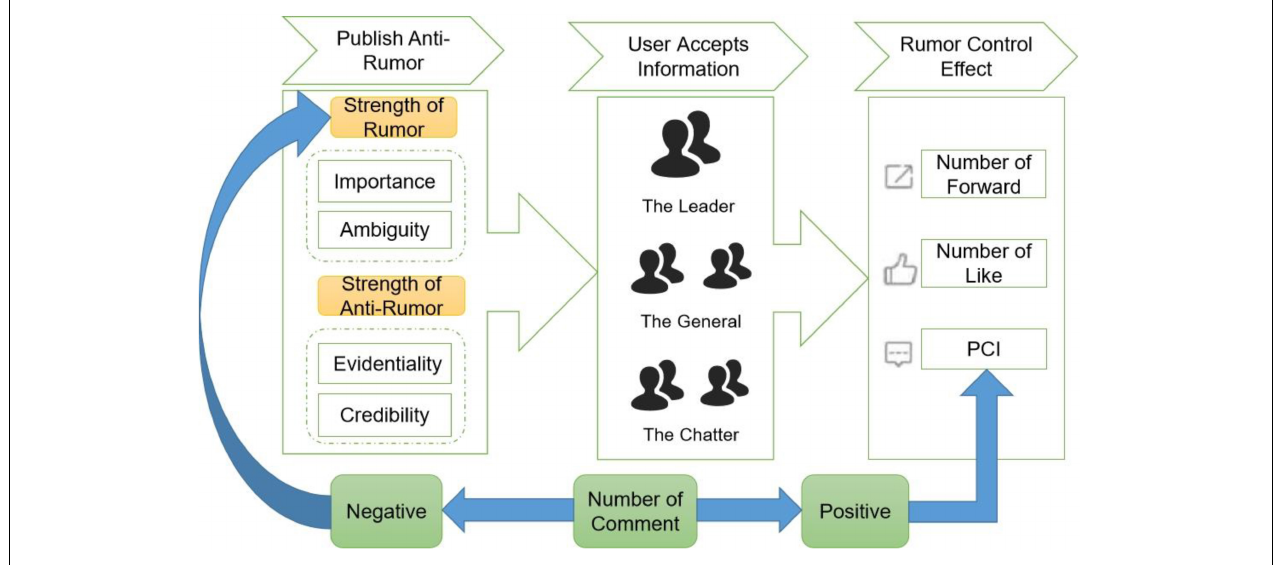
FIGURE 1 | Rumour control process based on releasing